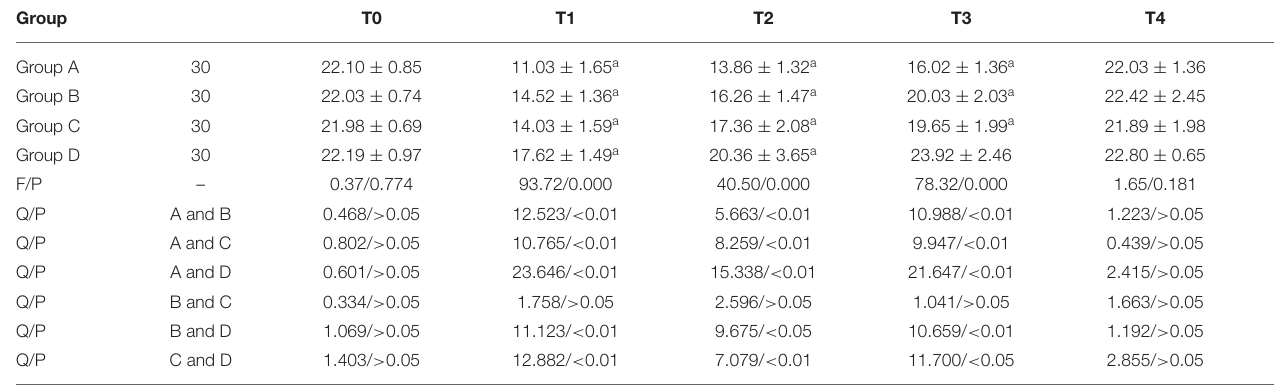
TABLE 4 | Comparison of NK expression among four groups (¯X ± s).